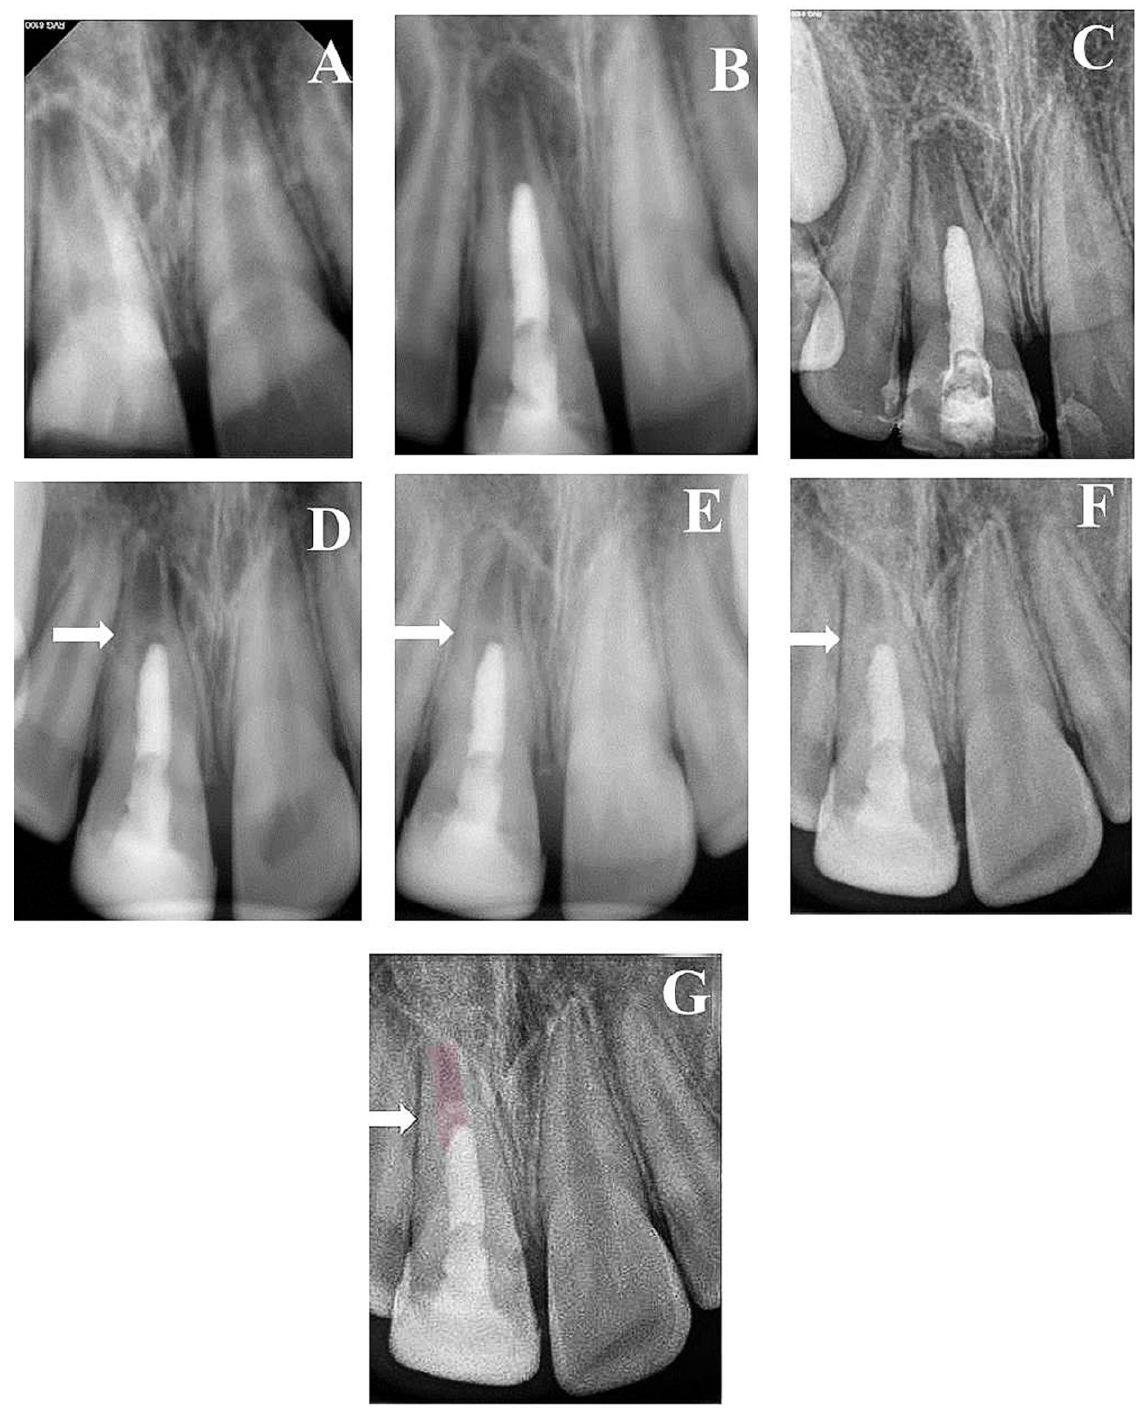
Figure 4. ( A ) Periapical radiograph of traumatized nonvital tooth #11 of an 11-year-old with wide open apex and periapical radiolucency; ( B ) immediate post-treatment radiograph showed MTA plug in the coronal third and composite restoration; ( C ) a follow-up photoradiograph after 6 months showed a complete resolution of the periapical radiolucency; ( D ) follow-up photoradiograph at 12 months showed evidence of radiopaque bridge (white arrow) under MTA orifice seal; ( E ) follow-up photoradiograph at 24 months showed narrowing in the apical canal area; ( F ) a follow-up photoradiograph at 8 years showed further reduction in apical canal width and thickening of canal dentin wall; ( G ) overlapped periapical radiographs of immediate post-treatment and at 8 years of follow-up showed significant changes in root length and width of apical canal.